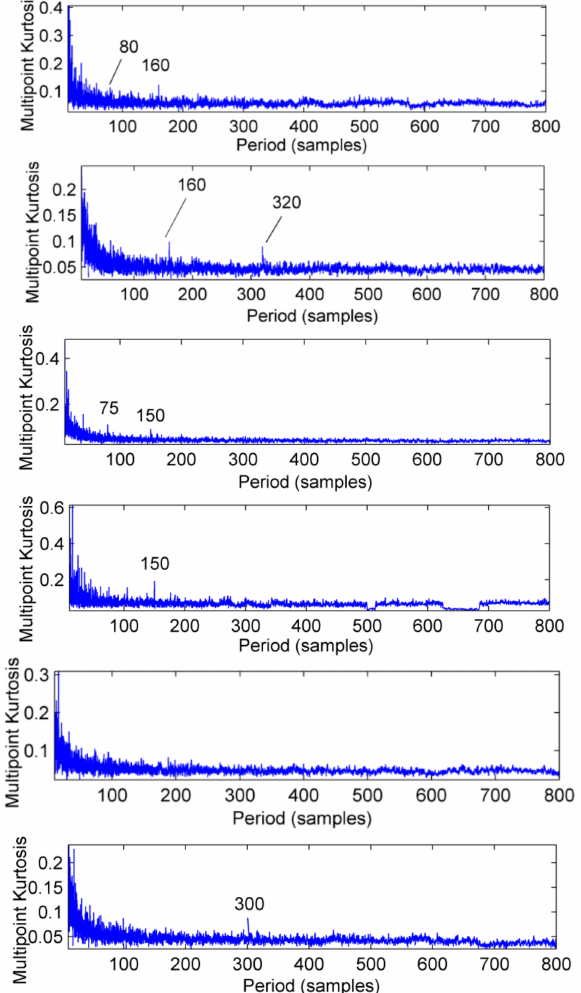
Figure 8. The multi-point kurtosis spectrum of the first six layers of